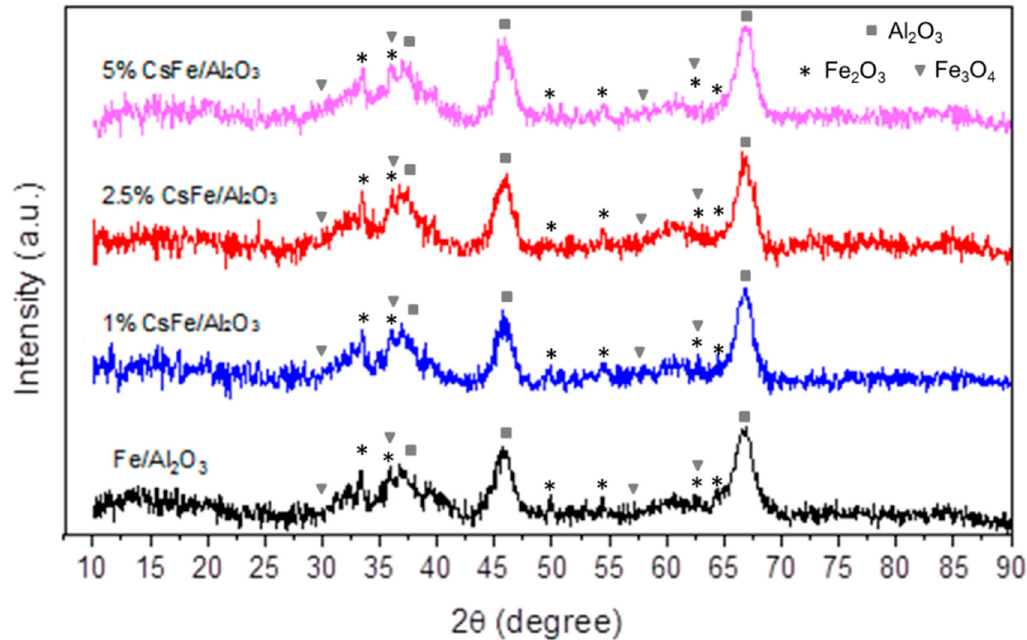
Figure 2. X-ray diffraction profiles of the calcined samples.